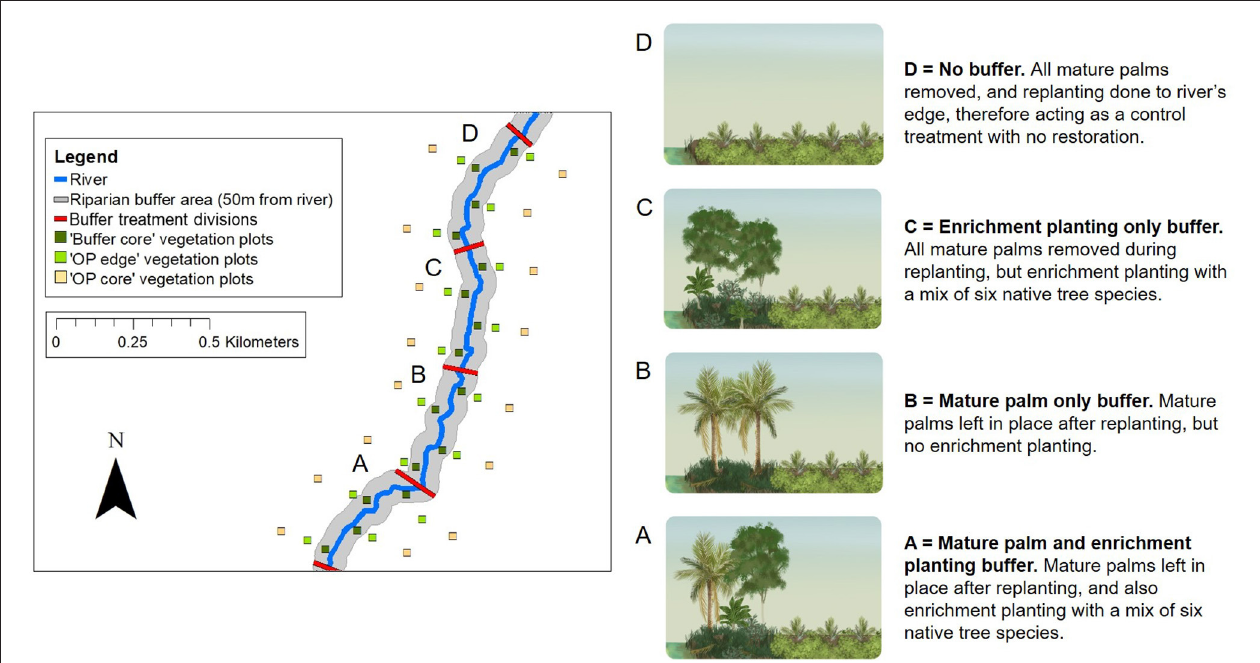
FIGURE 4 | Schematic to show the RERTA plot layout at the RERTA 1 site in Palapa Estate, along with diagrams and explanations of broad habitat conditions in different treatments (A–D) post-treatment. On the map, 25 × 25m vegetation plots are shown by green and yellow squares with the Buffer Core, OP Edge, and OP Core plots at each distance point along the river comprising a sampling triplet. The red lines across the river denote the treatment start and end points, whilst the grey shading represents the riparian buffer area. On the ground, each experimental riparian treatment is 50m wide (on each side of the river, and measured perpendicular to the river) and 400m long (measured along the path of the river), and survey measurements are taken up to 180m away from the river on each side (measured perpendicular to the river). The study site is therefore 360m wide, and 1,600m long in total. The area is transected by harvesting roads, but for clarity, these are omitted from the map. The same design is used at the RERTA 2 site in Kandista Estate. Re-planting and establishment of the riparian restoration treatments was completed at RERTA 1 in 2018, and at RERTA 2 in 2019. The map was made using ArcMap 10.5.1 ( Environmental Systems Research Institute (ESRI), 2017) with reference to maps produced by Sinar